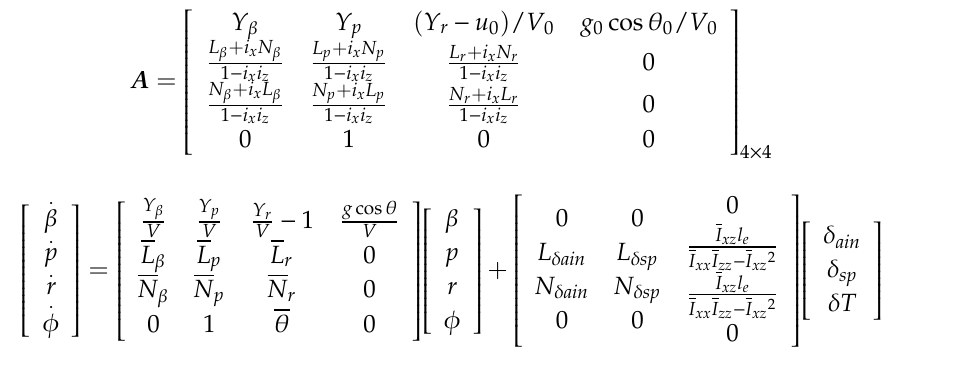
e ffi ciency factors all become zero, which means C Y β = C Yr = C Nr = 0. Since the vertical stabilizer works for the directional stability, then C N β = 0 and C Lr = C L /4.